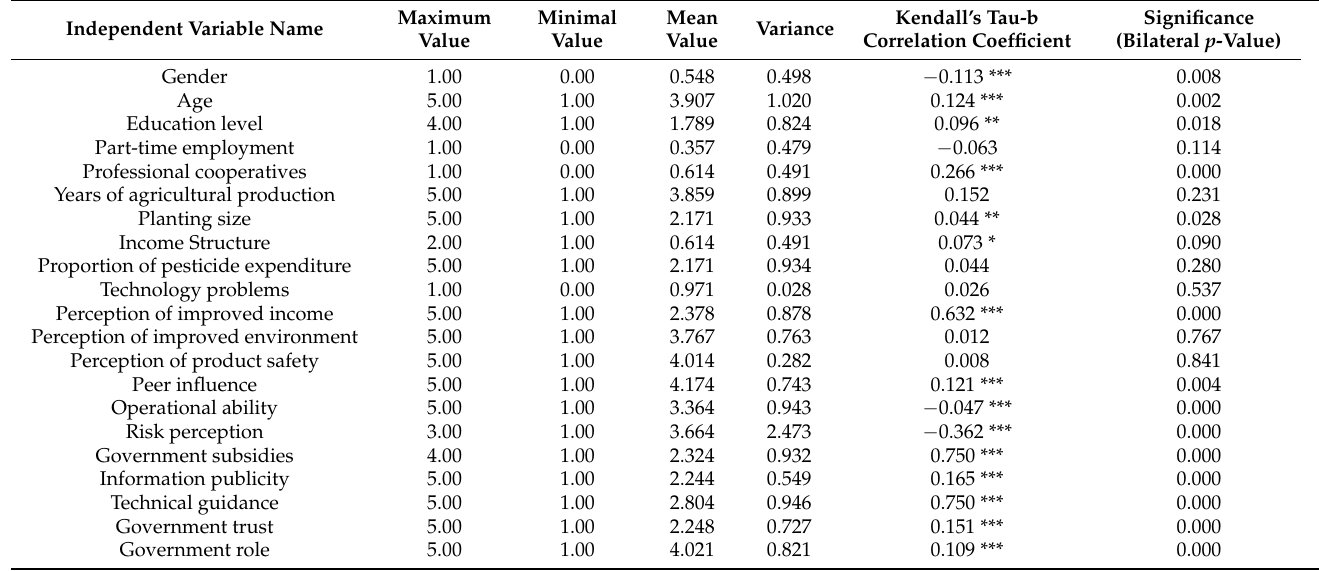
Table 5. Correlation analysis of independent variables and farmers’ willingness to respond to light trapping technology.